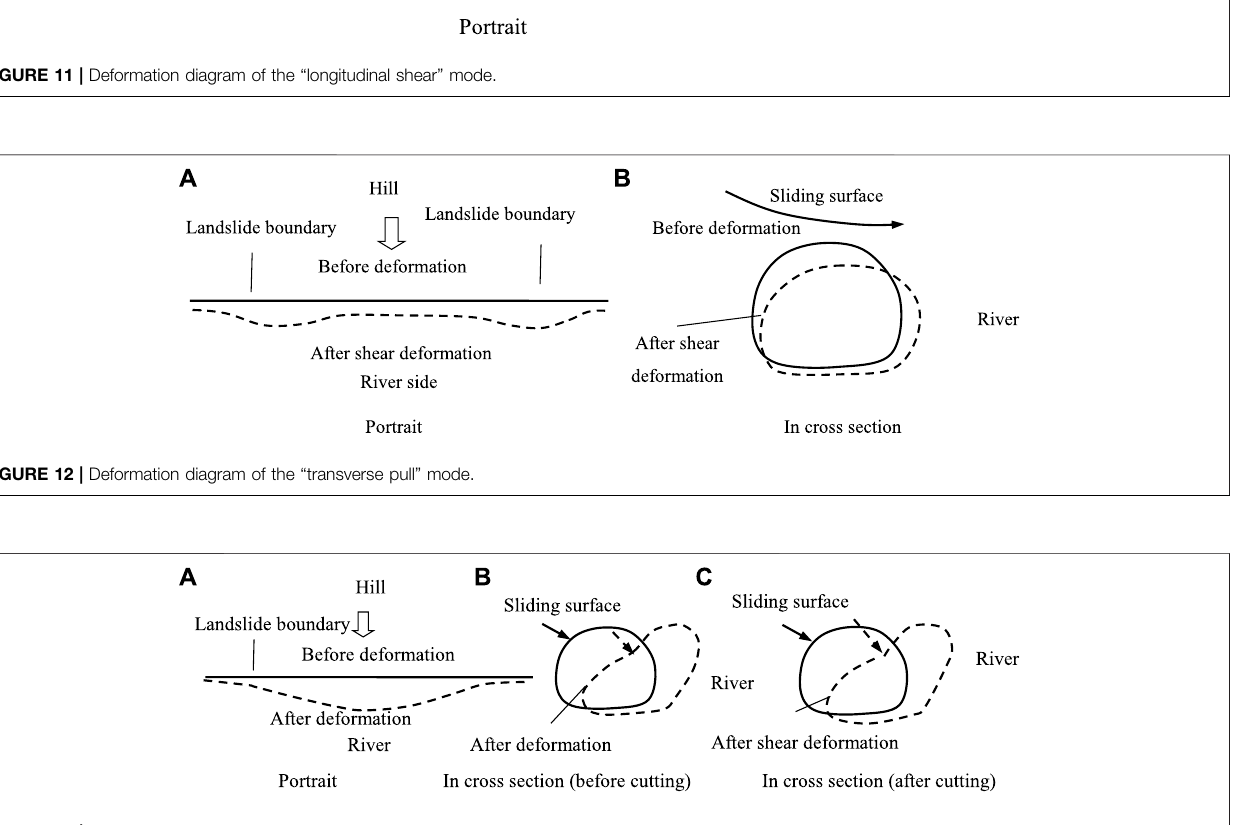
FIGURE 13 | Deformation diagram of the “ transverse shear ”